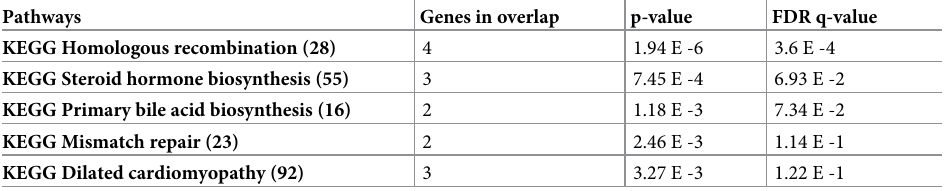
Table 6. Results from overlap analyses, Category 1. Pathway analysis of genes mutated exclusively in DCIS and pri- mary tumors, 147 in total. Pathways